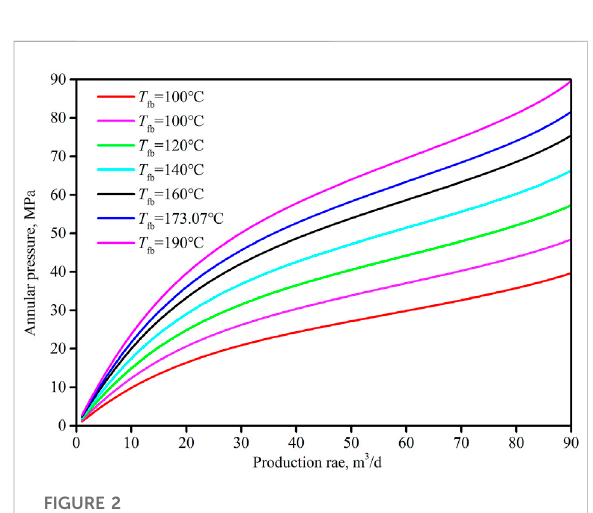
FIGURE 2 The changing law of the TAP as the production rate under different wellbottom temperatures.